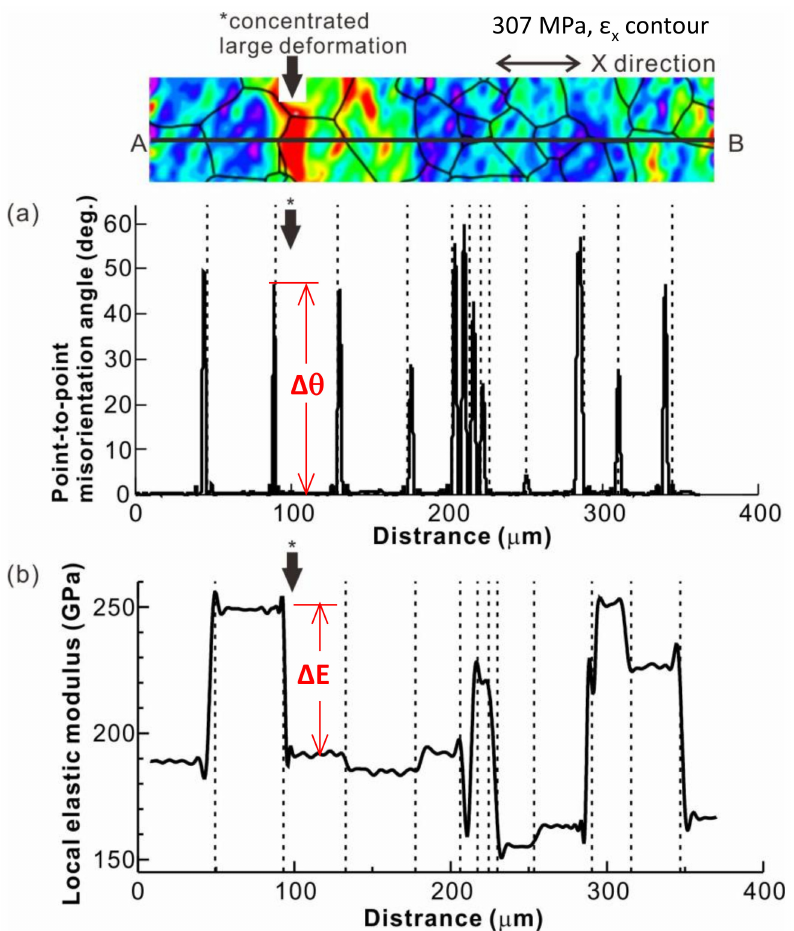
Figure 8. Distribution of ( a ) misorientation angle and ( b ) local elastic modulus along line AB. Dotted lines indicate the positions of grain